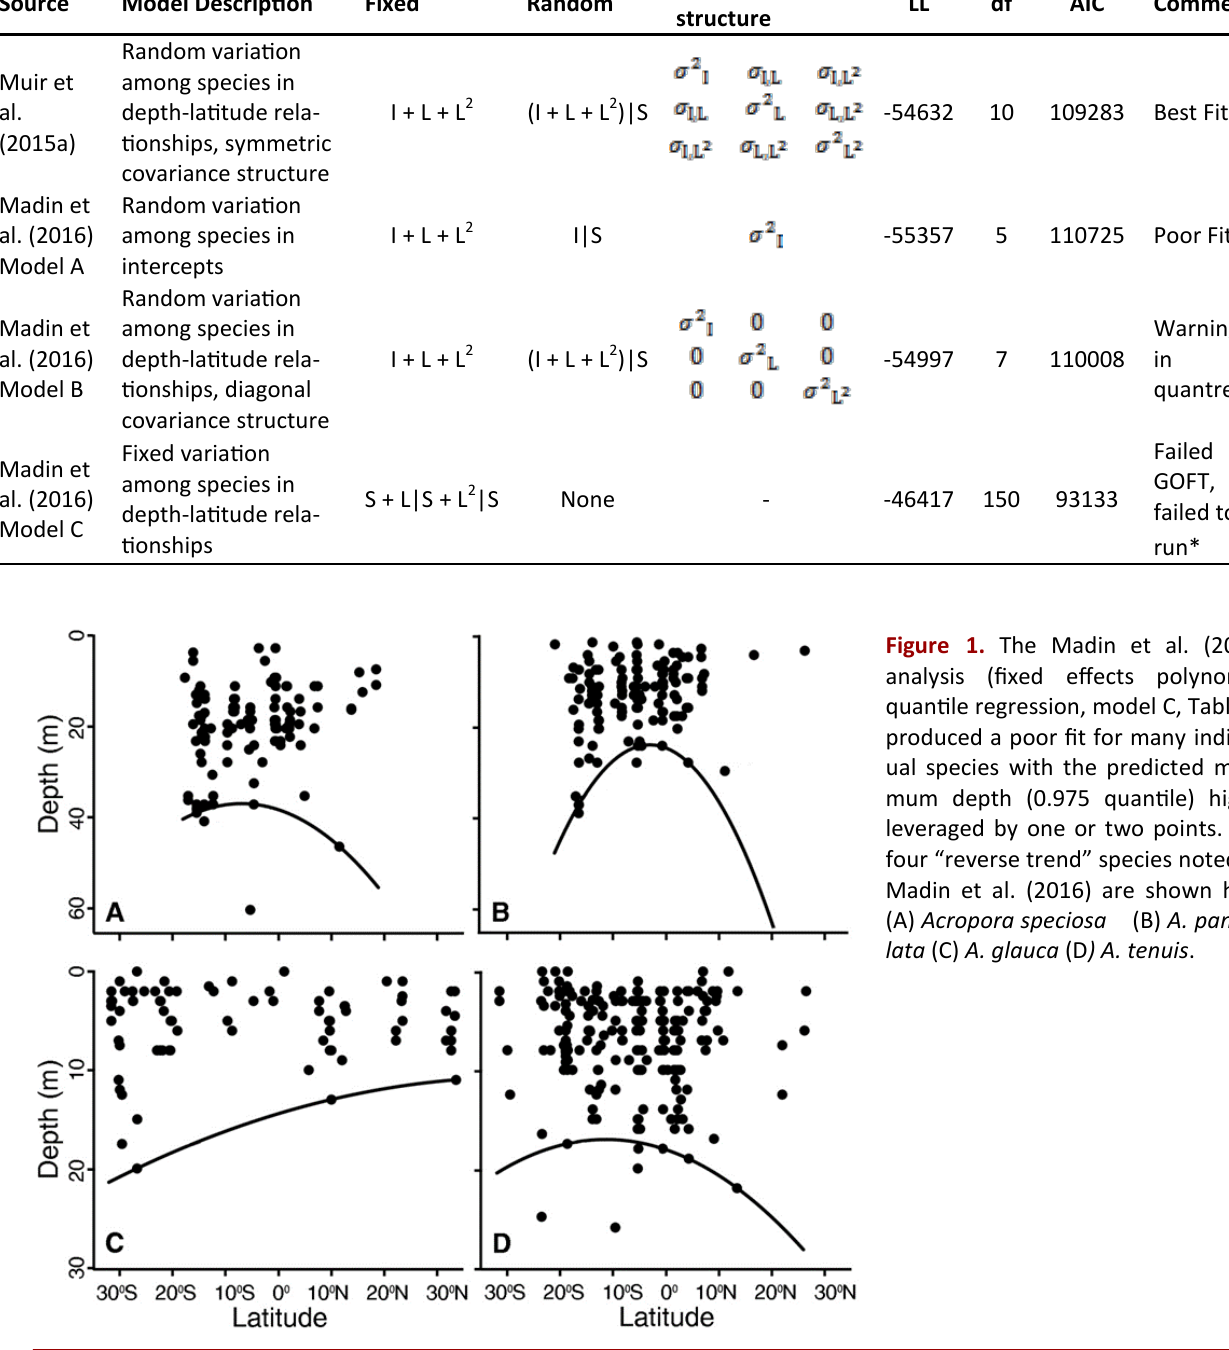
Table 1. Specifications for the polynomial quantile regression models discussed. *Madin model C fails the goodness of fit test (GOFT) for quantile regression models (GOFT = 2 x 10 -4 , p<0.001), is a poor fit to the data (Fig. 1) and terminates without pro- ducing an output in the current version of the quantreg R package (see text). GOFT is currently not available for mixed quan- tile regression models. Muir et al. (2015a) model is best fit compared to the remaining valid models Madin A and B (ΔAIC = 1442 and ΔAIC = 725 respectively). Note that ΔAIC cannot be used for comparison with Madin model C which uses a